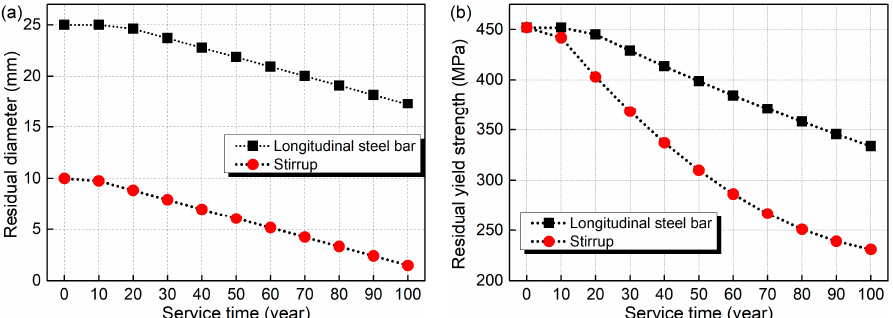
Figure 3. Estimated result of time-dependent steel bars performance influenced by chloride corrosion: ( a ) residual diameter; ( b ) residual yield strength.